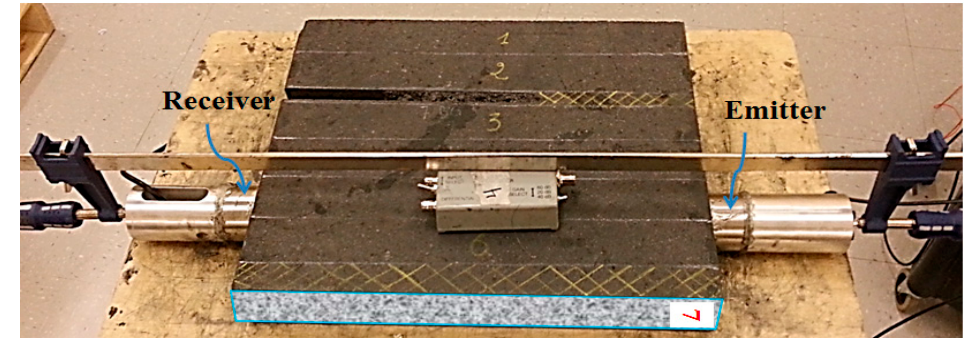
Figure 4. Acoustic data acquisition set up through different corridors of an anode slice. The corridors are identified by numbers in the figure.